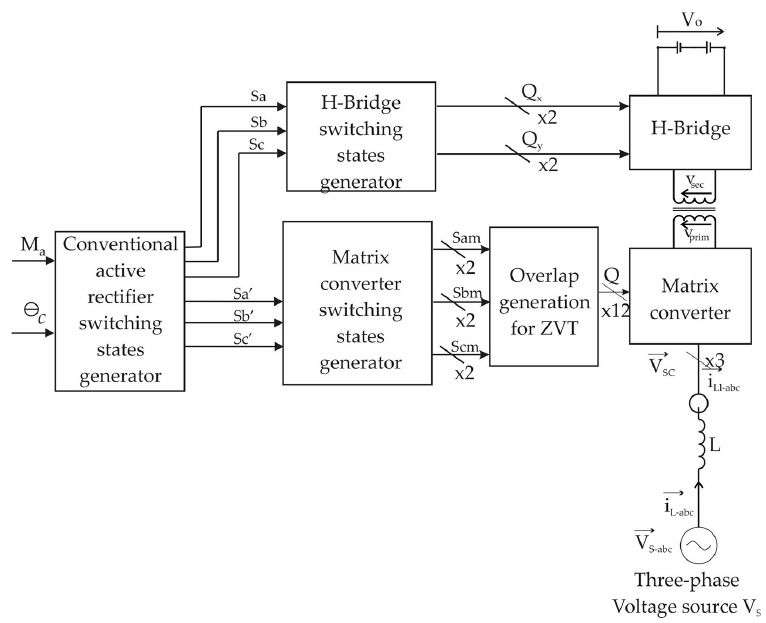
Figure 5. Block diagram for AC-DC operation of the modular converter of Figure 1b.